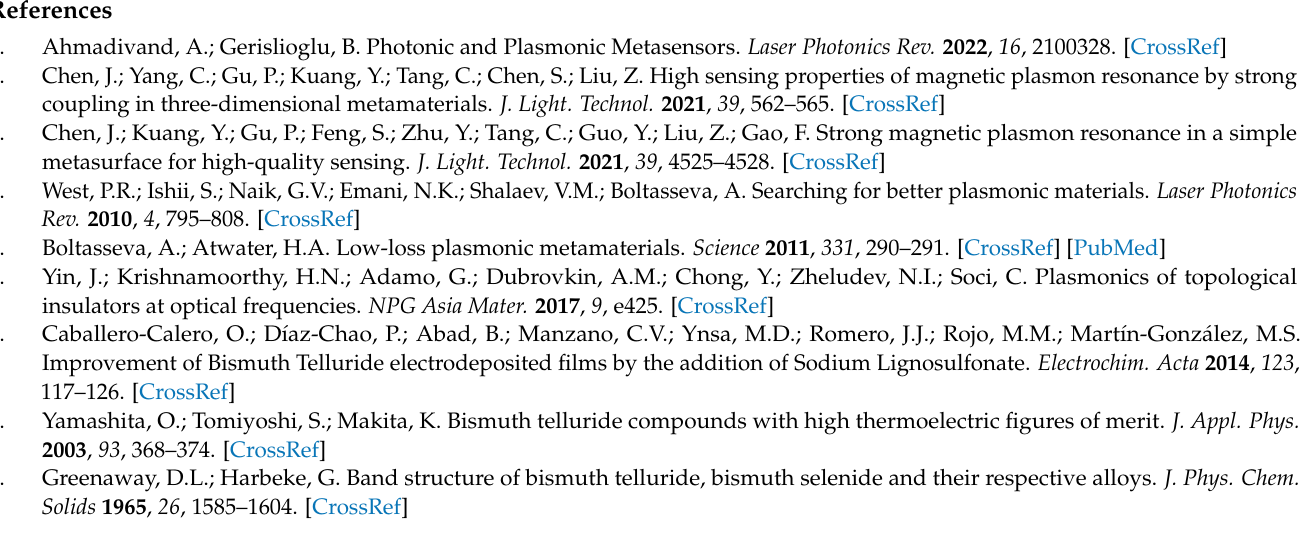
Figure A3. Experimentally obtained ( a ) real and ( b ) imaginary optical constants of Bi 2 Te 3 (black and gray lines) and Ni (blue line).